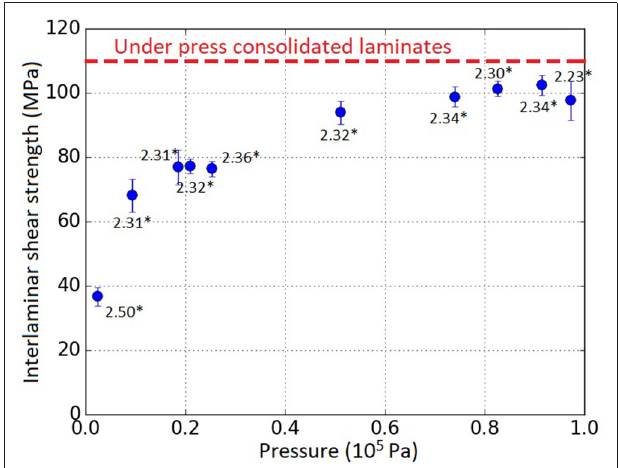
FIGURE 12 | Results of ILSS measurements for different compaction pressure levels in the heated oven (*: average thickness of the laminate in mm ).